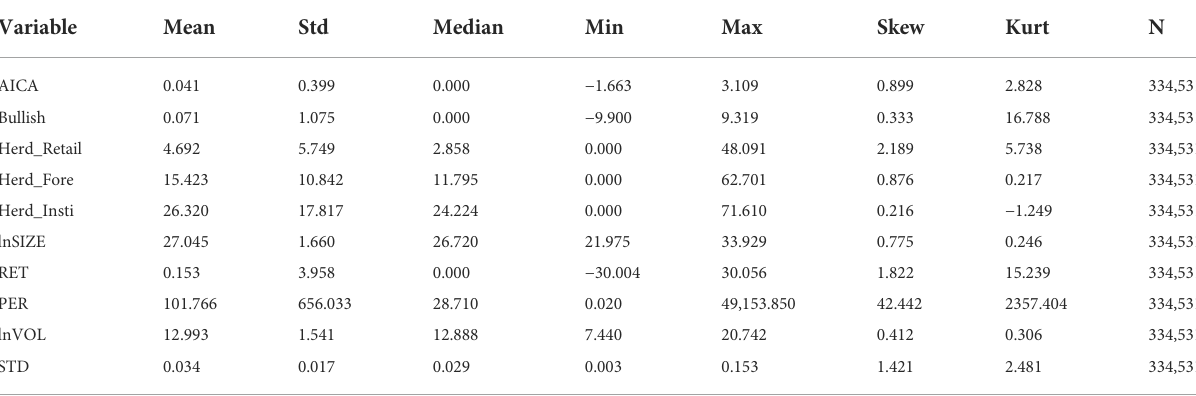
TABLE 1 Summary statistics. Table reports the summary statistics of regression variables used in regression analysis. AICA is abnormal information creationactivity.Bullishisaninvestmentsentimentindicatorthatrepresentsanopinionscore.Herd_Retail,Herd_Fore.andHerd_Insti.areretail, foreign and institutional herding behavior measures, respectively. lnSIZE is the value taking the natural log of market capitalization. PER is the P/E ratio. lnVOListhe valuetaking thenaturallog ofthetrading volume.STDisthe standarddeviationofdaily returns fromtheprevious 3 months. Panel A represents summary statistics of regression variables, and Panel B represents the correlation between regression variables. Panel A. Summary statistics of regression variables